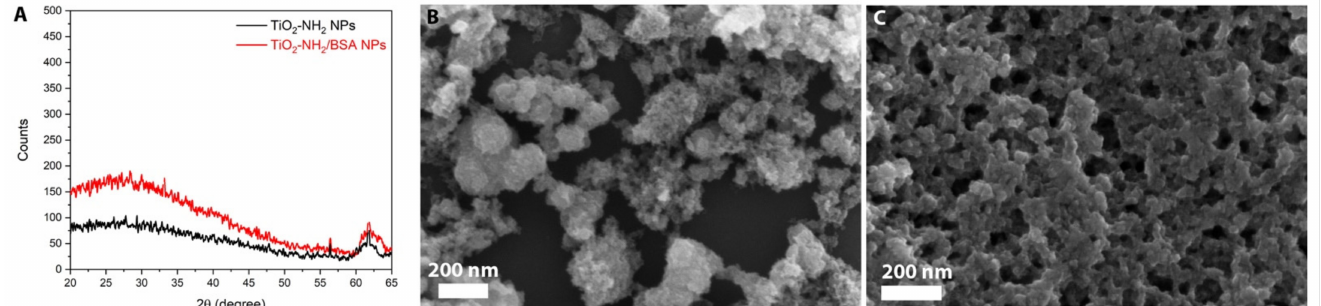
Figure 1. ( A ) X-ray diffraction pattern of aminopropyl-functionalized amorphous titania before (black curve) and after BSA coating (red curve); FESEM images of ( B ) a-TiO 2 -NH 2 and ( C ) a-TiO 2 -NH 2 /BSA.